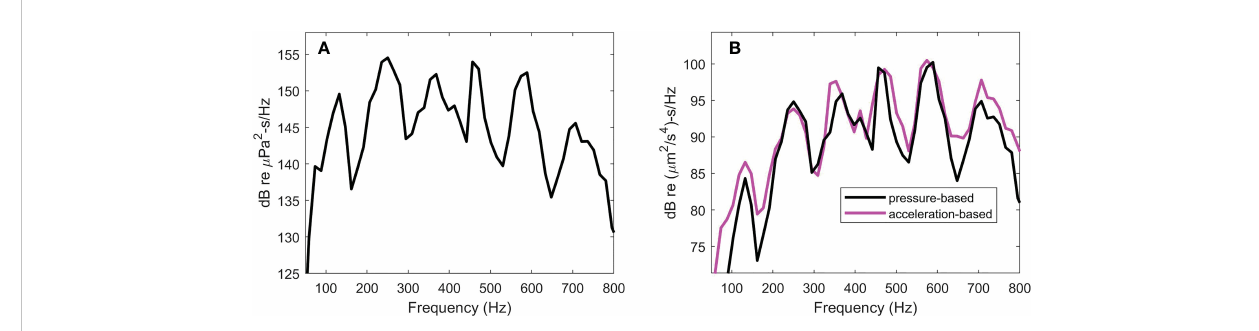
FIGURE 8 Spectral densities for pile T5, range 16 m (A) Sound exposure level (SEL) spectral density S p ( f ) (B) Acceleration exposure spectral density as derived with pressure data A p ( f ) (black line) and velocity data A k ( f ) (magenta